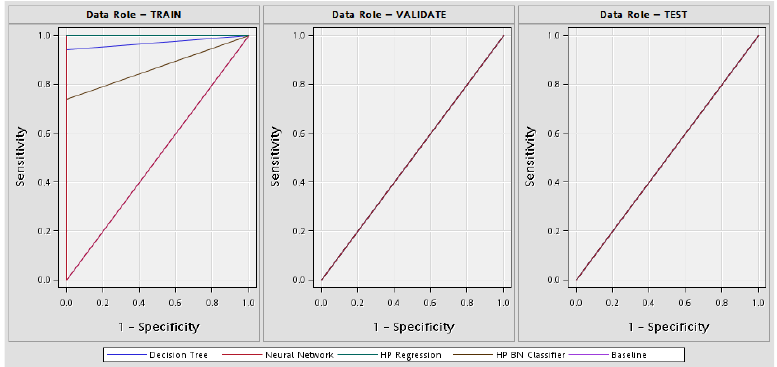
Figure 11. ROC curve comparison